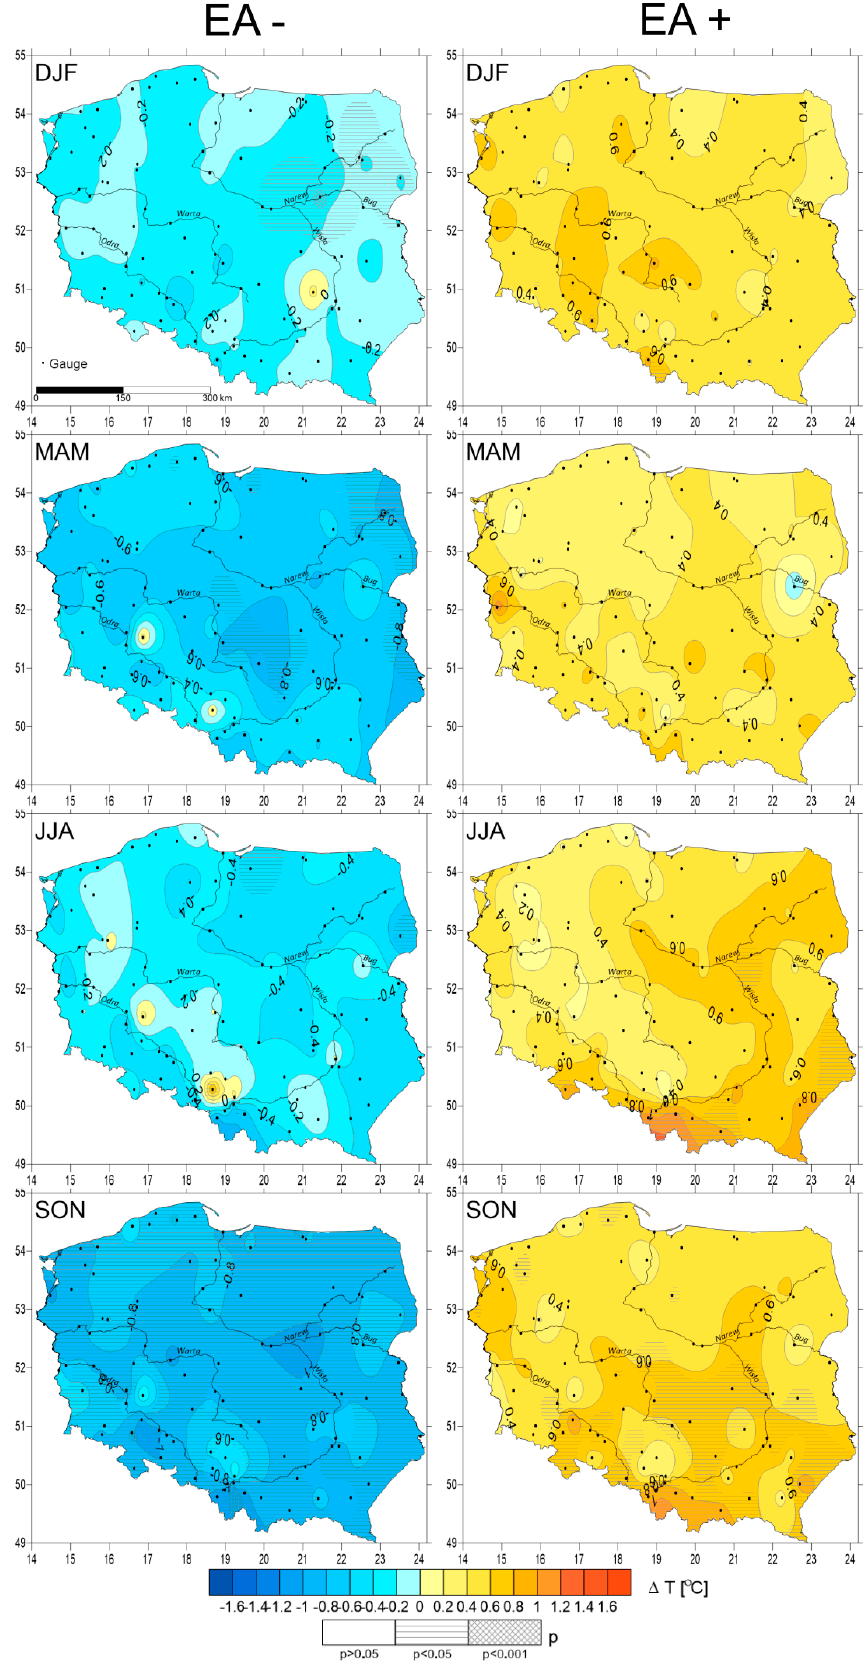
Figure 8. Spatial distribution of seasons deviations of water temperature ( ∆ T) in various EA phases from average values for the years 1971–2015 and their statistical significance (p).